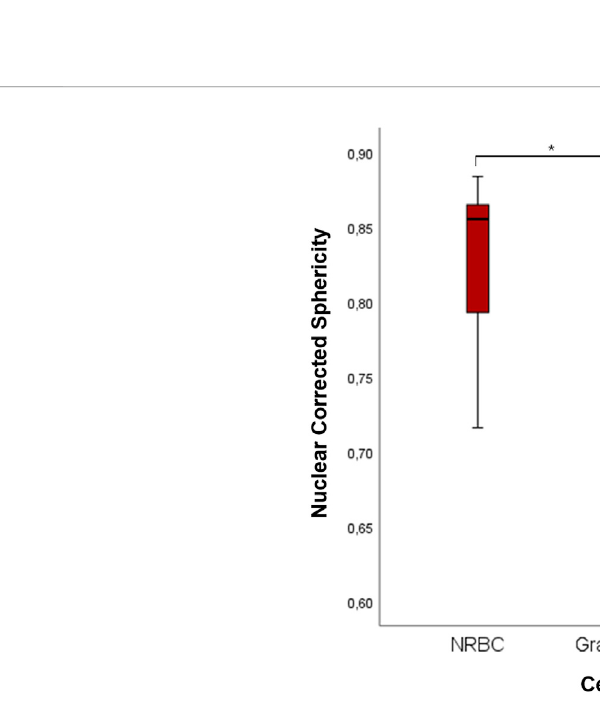
Likely, these changes can be attributed to the different membrane and cytoskeleton characteristics and how they react to the fi xation process. For instance, in the presence of CR, red blood cells ’ diameter